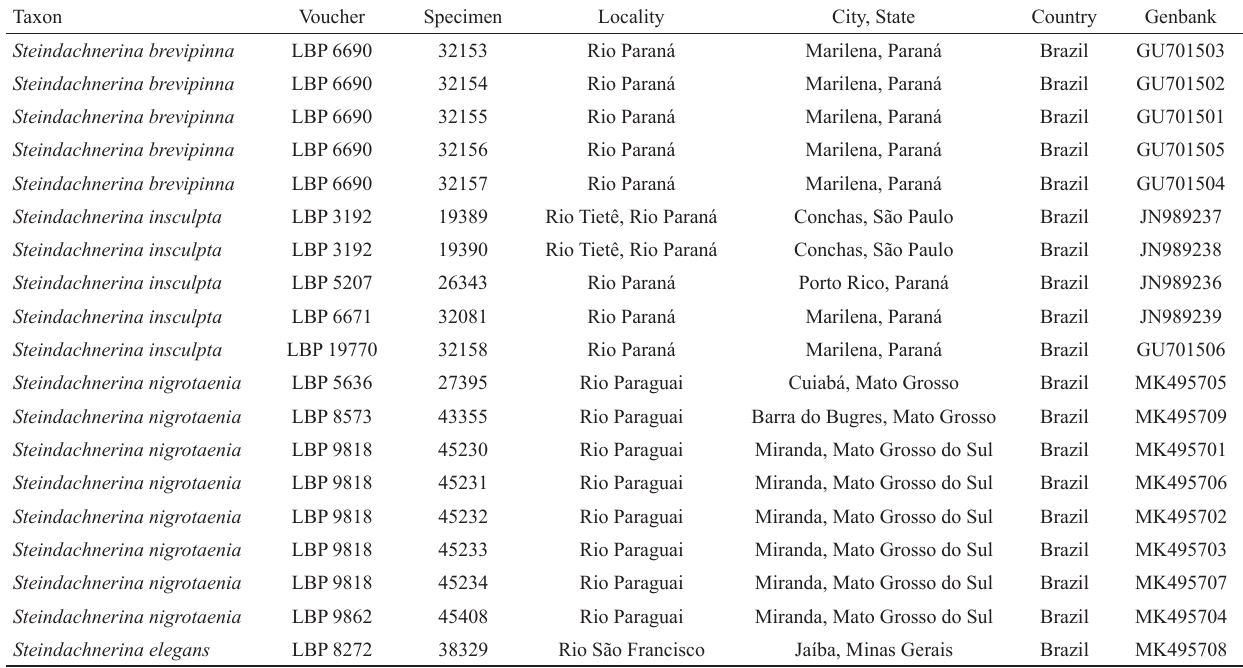
Tab. 1. Taxon, voucher, locality information and Genbank accession numbers of specimens of Steindachnerina analyzed in the molecular approach